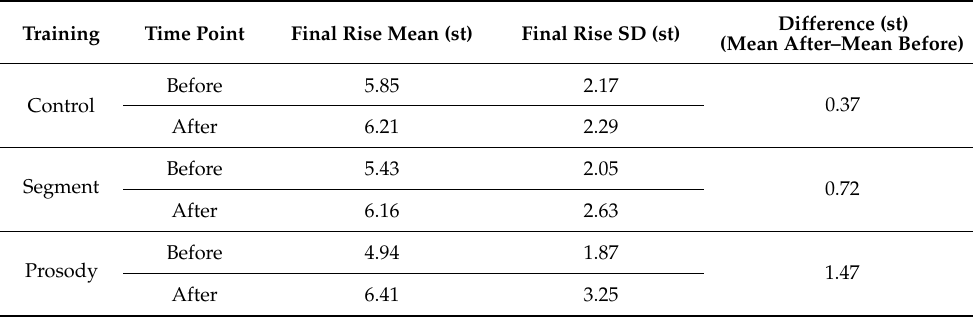
Table 2. Results for the final rise of the three training groups in semitones